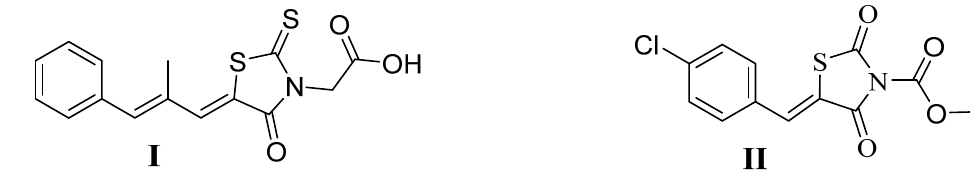
Figure 3. Epalrestat ( I ) (aldose reductase inhibitor); Mycosidine ( II ) (topical antifungal).